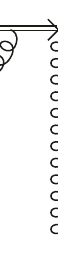
Figure 5 . One-loop correction to quasi gluon distributions, which involves one Wilson line and both the endpoints of internal gluon line connect to the Wilson line. The double line is the Wilson line. The cross “ ” denotes the non-local vertex from the operator structure of ×